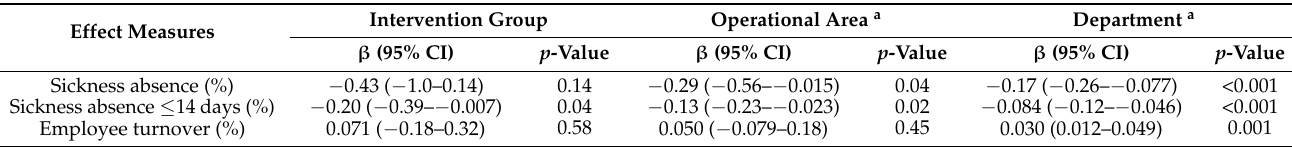
Table 1. Estimated intervention effects on sickness absence and employee turnover in the intervention groups, and concurrent changes in the reference